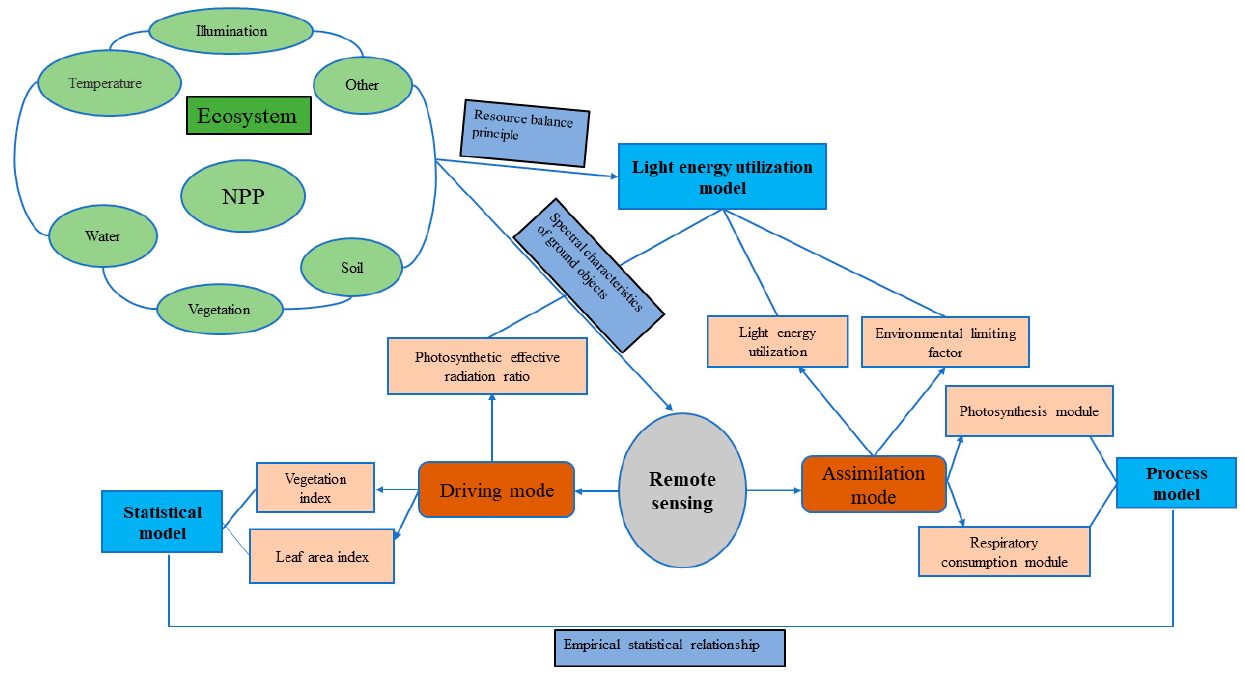
Figure 2. Typical process of remote sensing data intervention in NPP estimation model (adapted from Hong [11]).